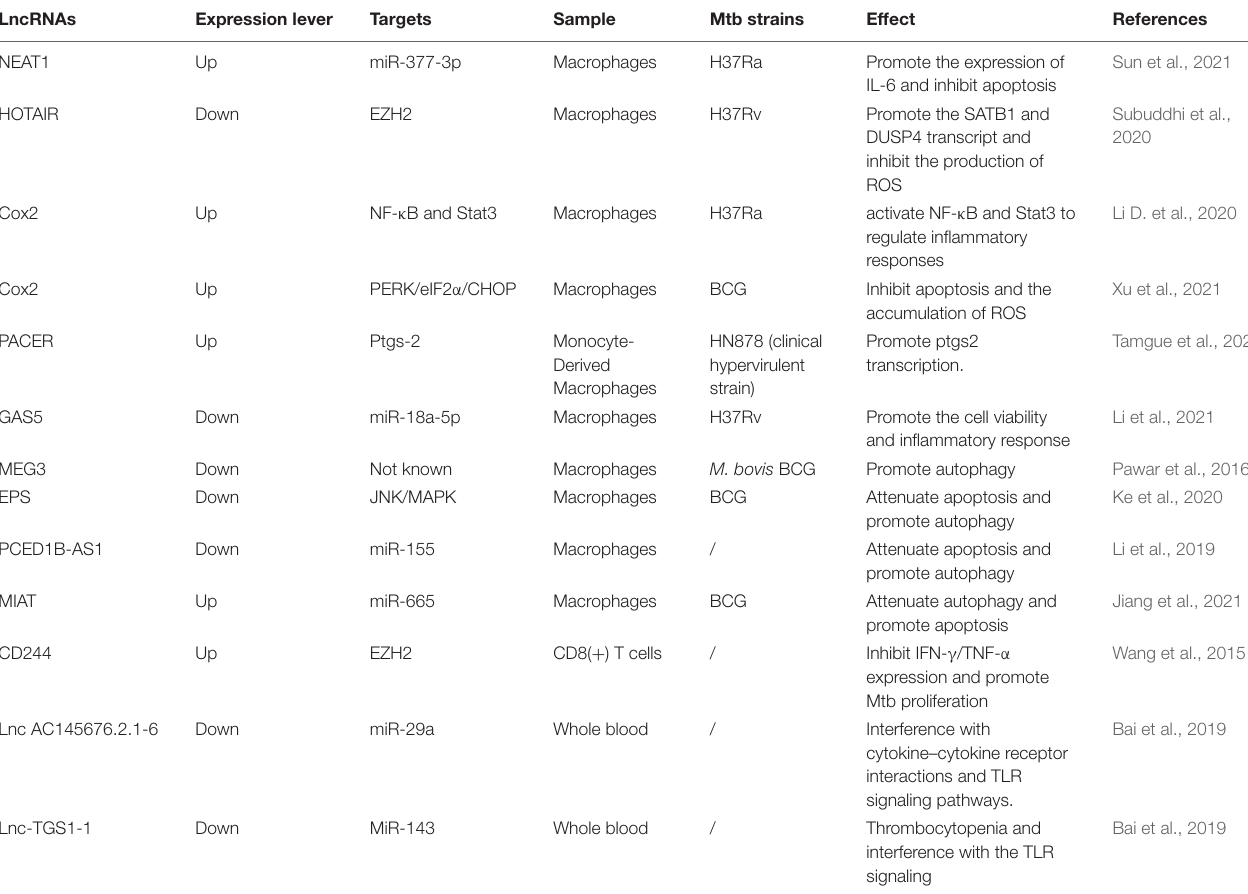
TABLE 1 | The regulatory role of lncRNAs in anti-TB